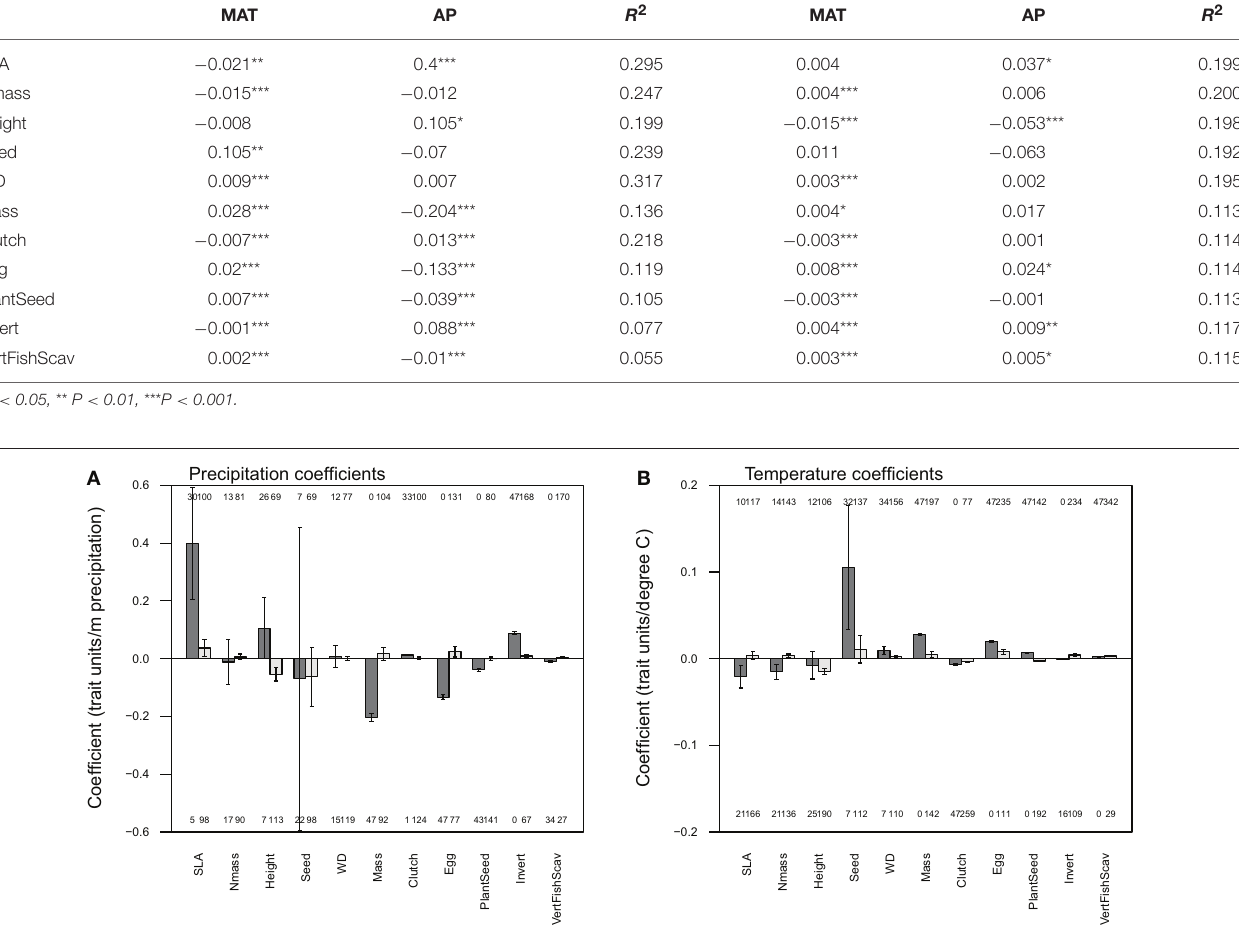
relationships between temperature and WD were positive, ( Supplemental Figure 7 ). The negative correlation